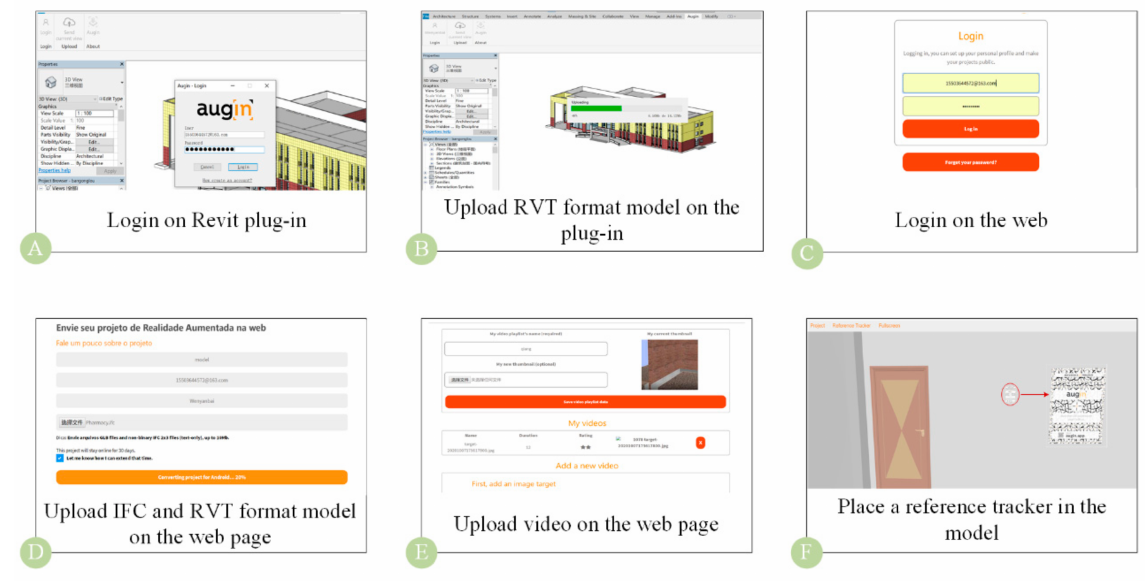
Figure 7. Uploading data to the AR platform.